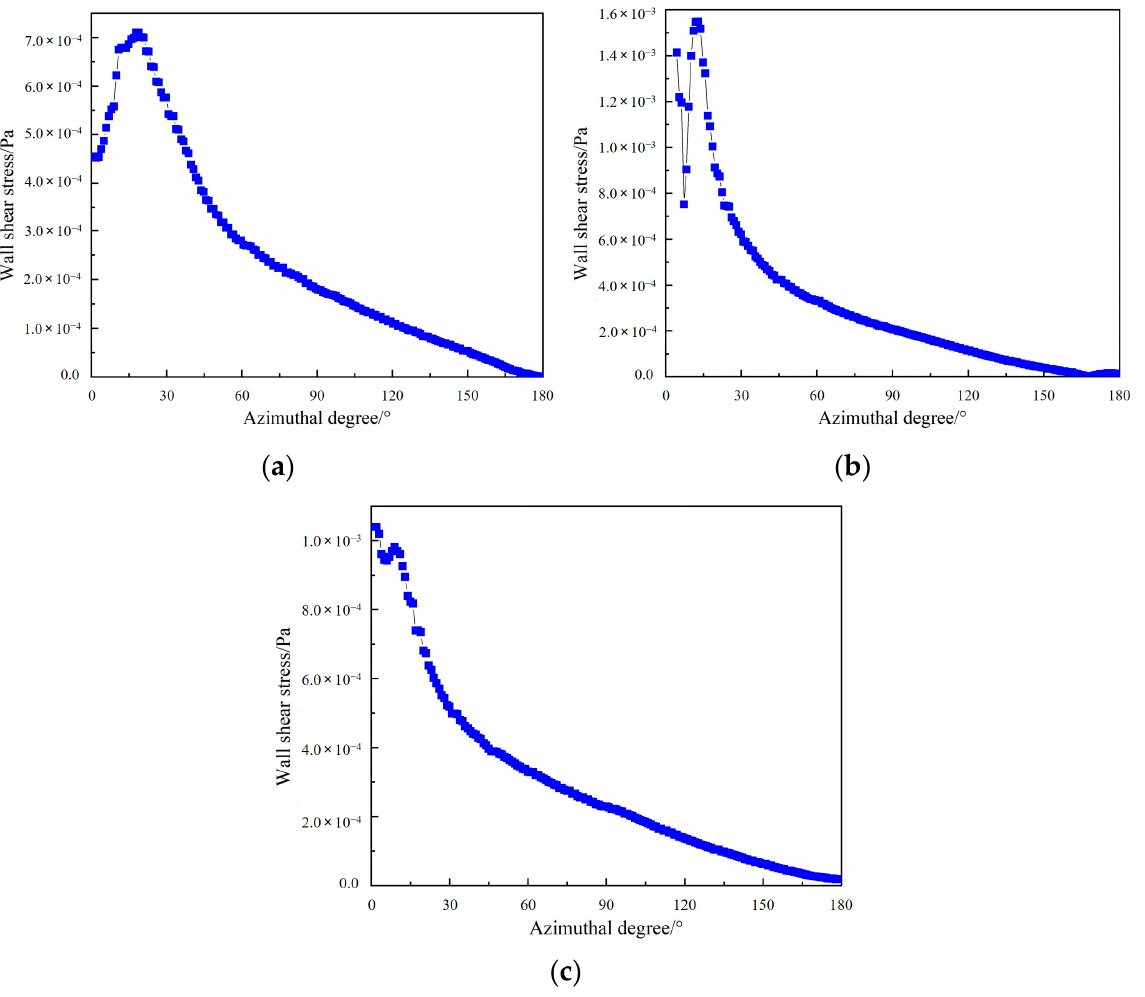
Figure 5. Shear-stress distributions on the inner-sidewall at the height of ( a ) 0.5 m, ( b ) 1.5 m, and ( c ) 2.5 m from the hearth bottom.